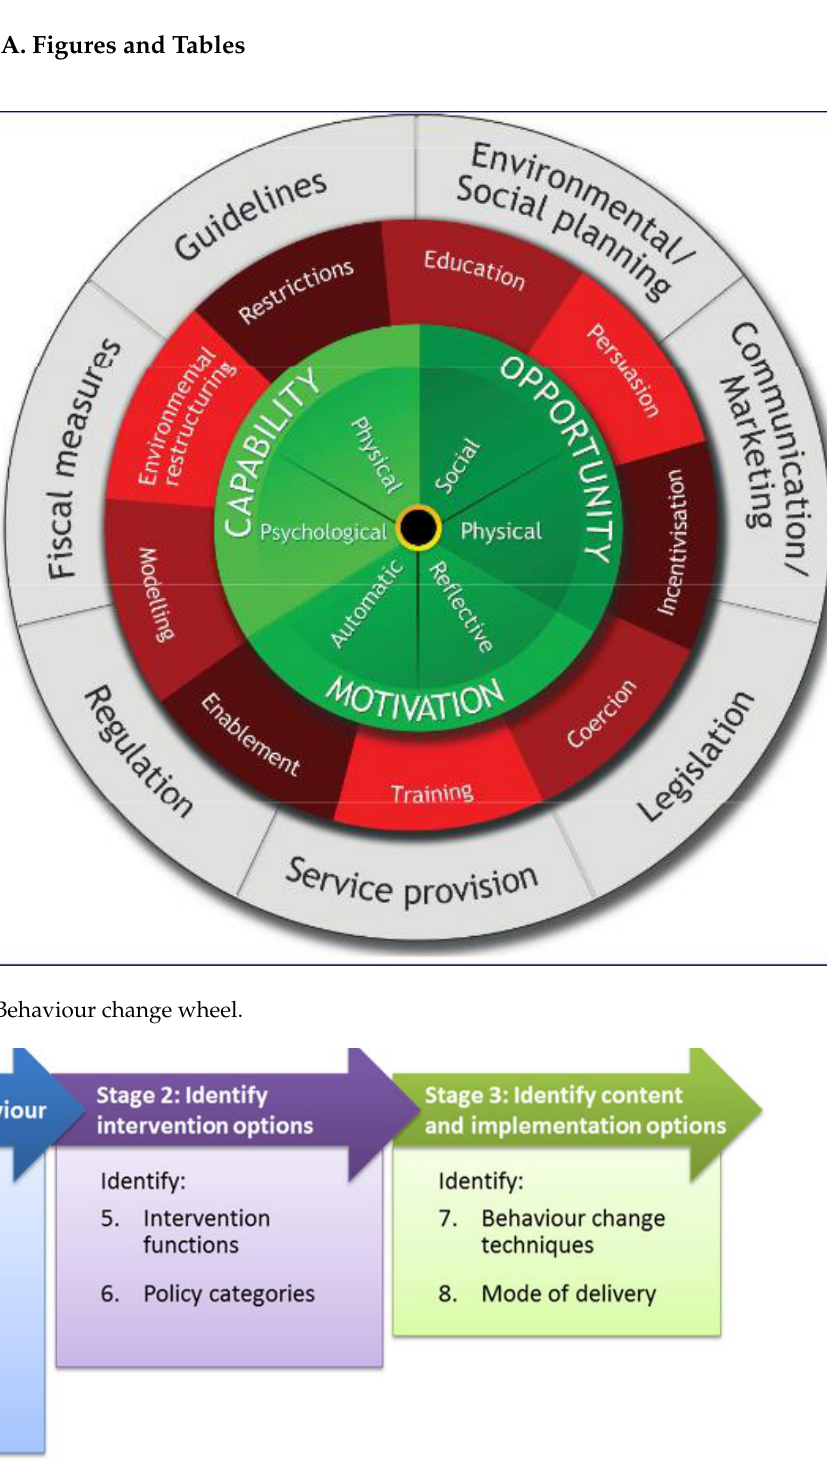
Figure A2. Behaviour change intervention design process. Table A1. Target behaviour categories (survey item) identified for the co-design workshops along with the number of reported fatalities associated with it and the percentage of farmers mentioned it in the focus group.